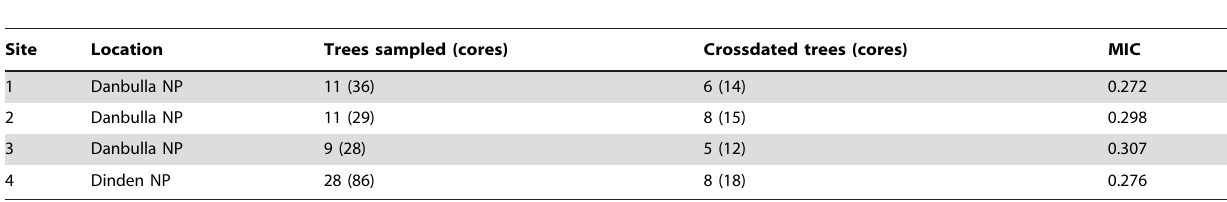
Table 2. Chronology statistics for A. robusta at four sites in the Atherton Tablelands, northern Queensland, Australia.